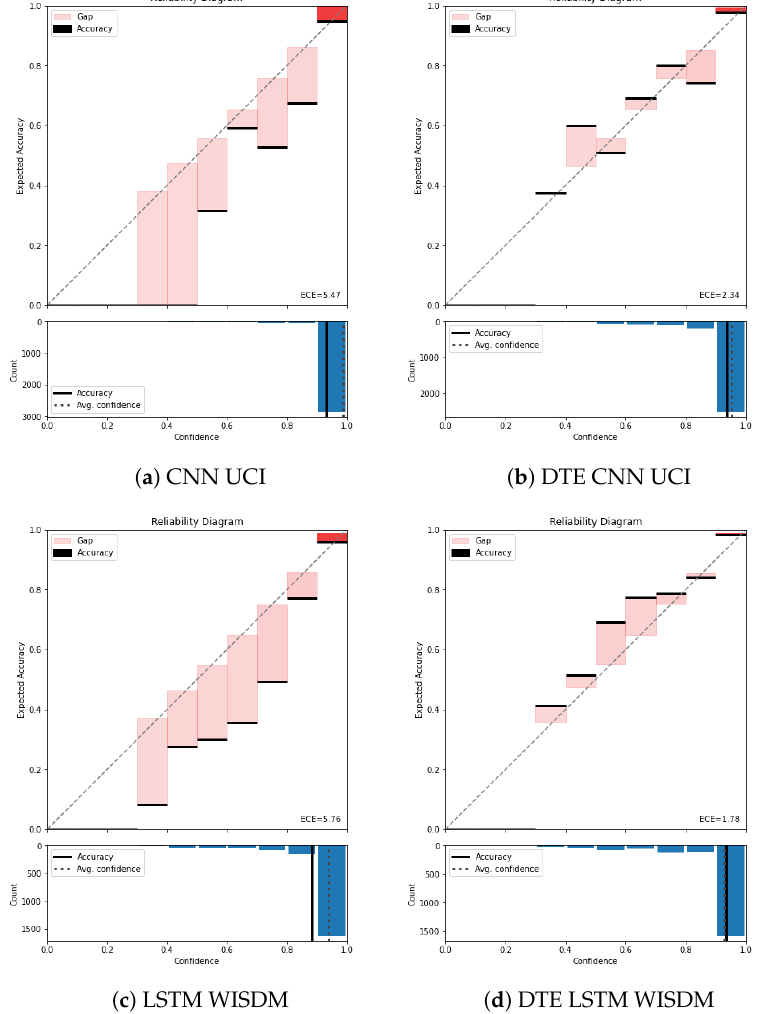
Figure 5. Reliability diagram UCI and WISDM : Without temperature scaling . The top half of each reliability diagram ( a – d ) has confidence in the x -axis and accuracy in the y -axis. The x -axis (confidence) is divided into 10 bins. The colored bars represent the difference between mean accuracy and the mean confidence of the samples that falls in those bins. The black line on top or bottom of each bar represents the accuracy of the samples in that bin. The bottom half of the reliability diagram represents the histogram of the samples concentrated in each bin. The ECE is calculated be averaging the difference between confidence and accuracy across all the